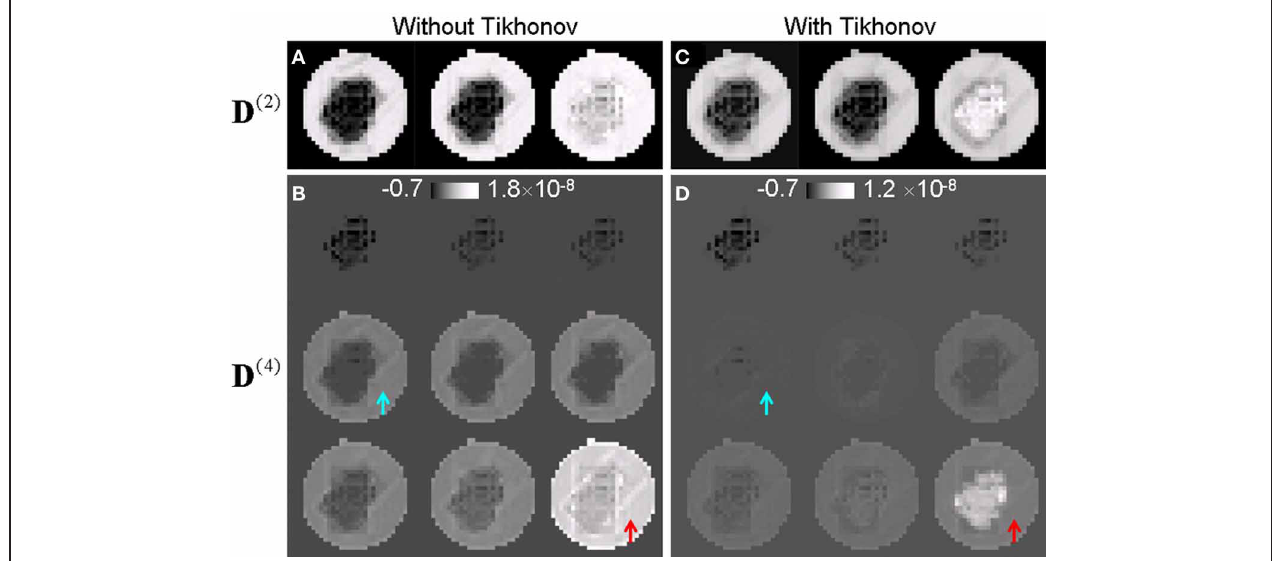
FIGURE 2 | Higher-order tensors estimated with and without Tikhonov regularization. (A,B) Eigenvalues of the second and the fourth order tensor estimated without regularization. The fourth order tensor was overestimated